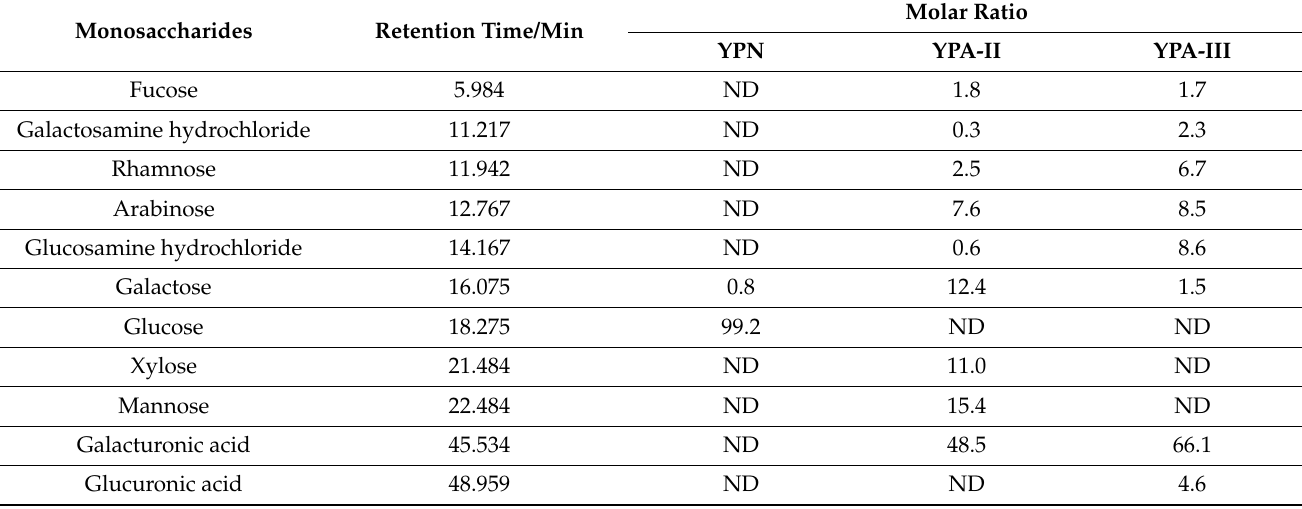
Table 3. IC data analysis of yam polysaccharide